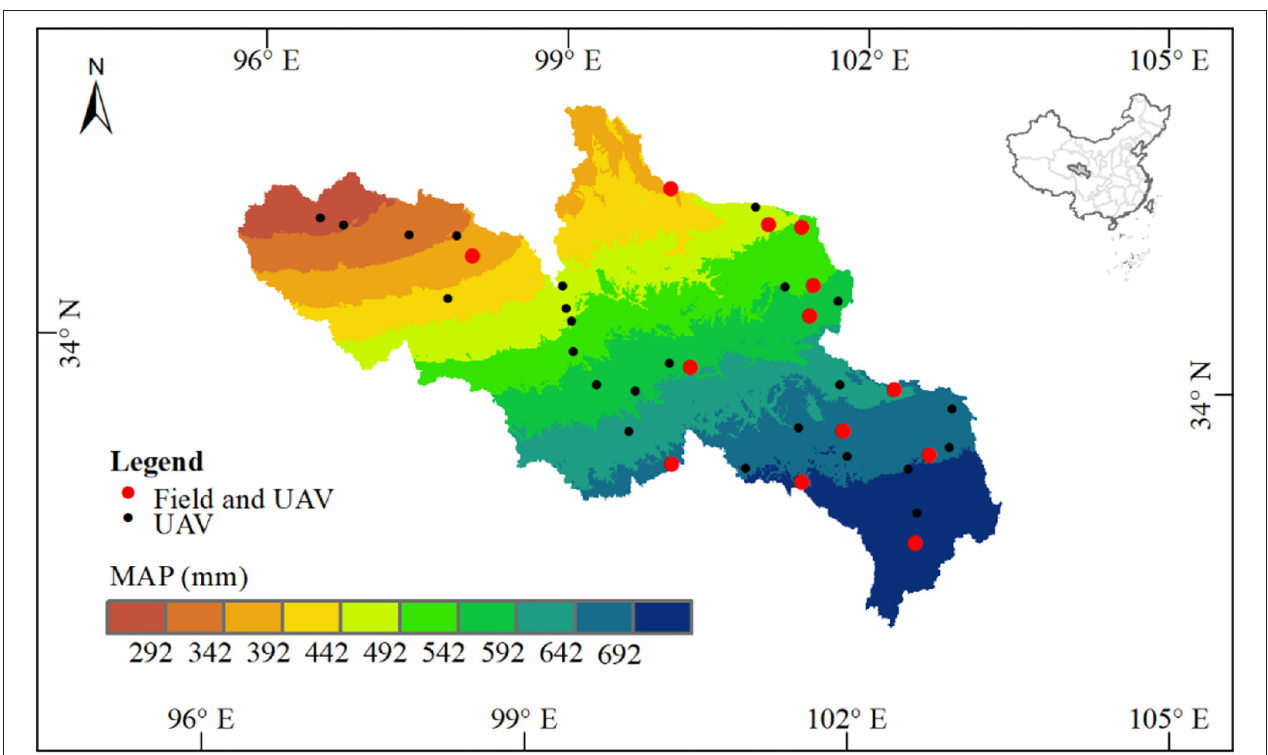
FIGURE 1 | Spatial annual precipitation (mean of 2000–2017) and the location of sampling sites among the source region of the Yellow River on the Qinghai-Tibetan Plateau.